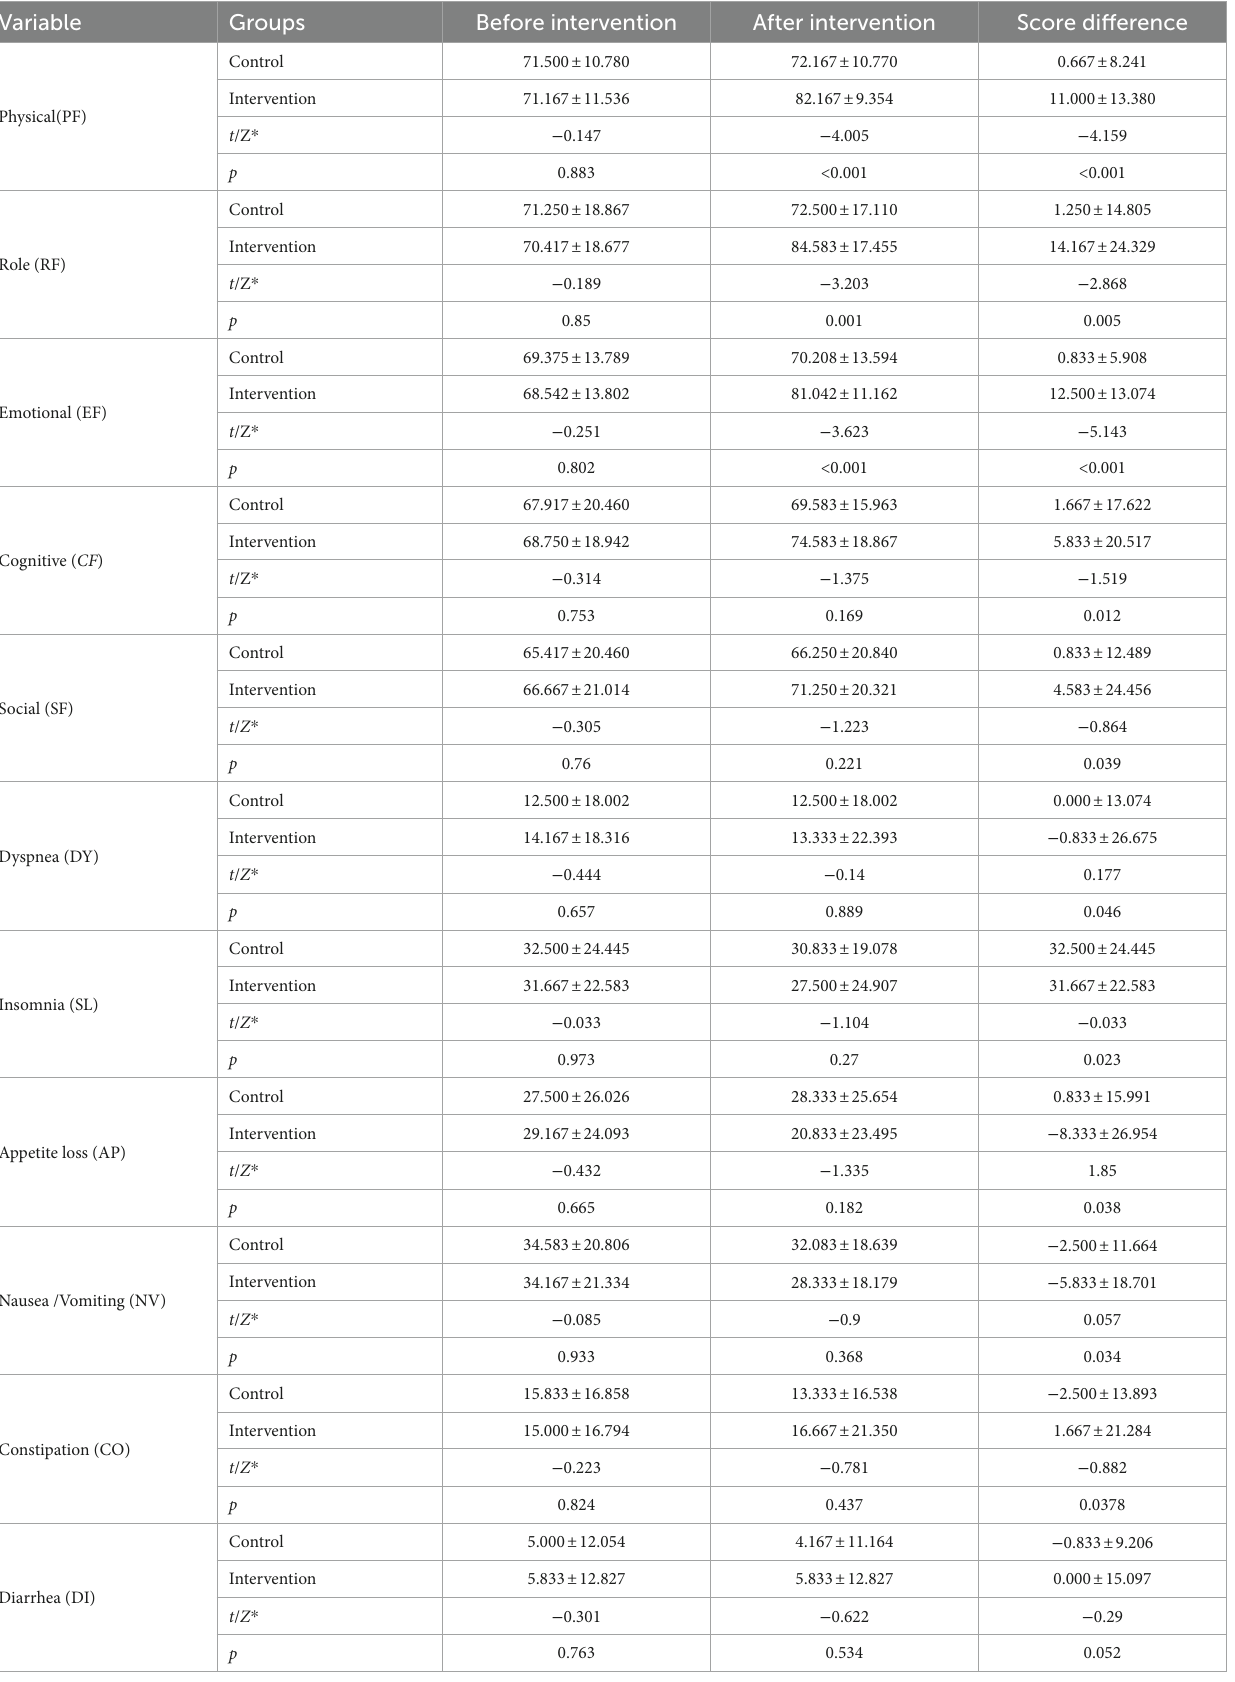
TABLE 3 Comparison of quality of life scores of breast cancer patients in different groups before and after intervention ( n = 80). Variable Groups Before intervention After intervention Score